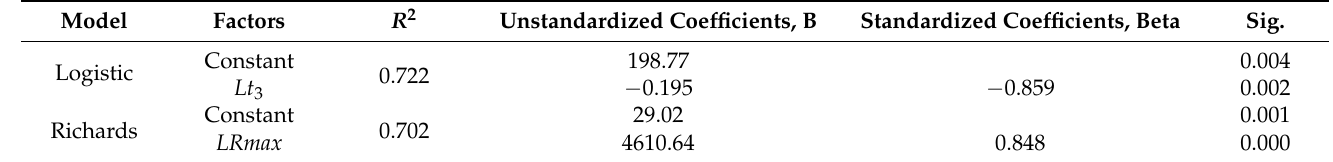
Table 4. Regression coefficient